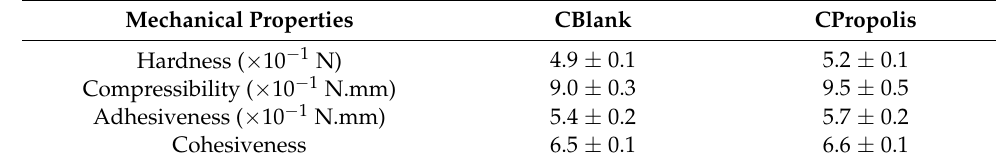
Table 1. Mechanical properties of CBlank and CPropolis at 25 °C.